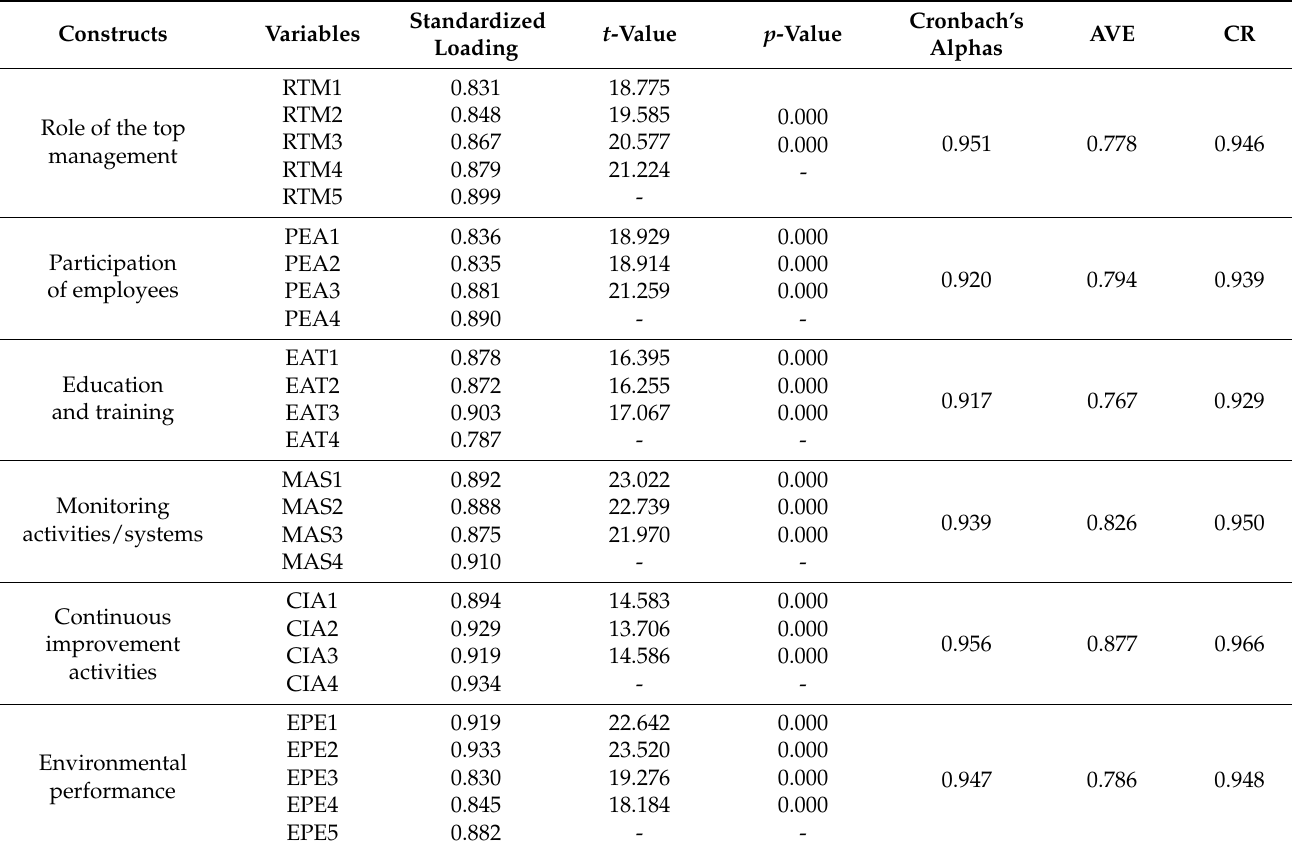
Table 5. Results of Cronbach’s alpha, AVE, composite reliability, and